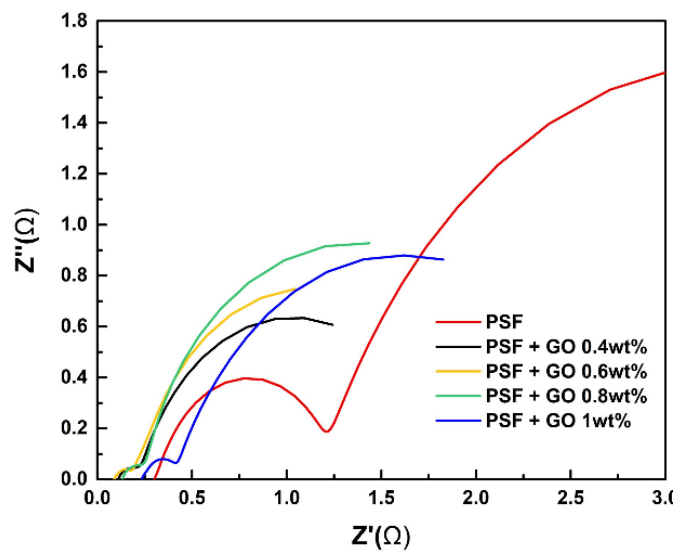
Figure 8. Nyquist plots of various PSF/GO membrames from EIS measurement.